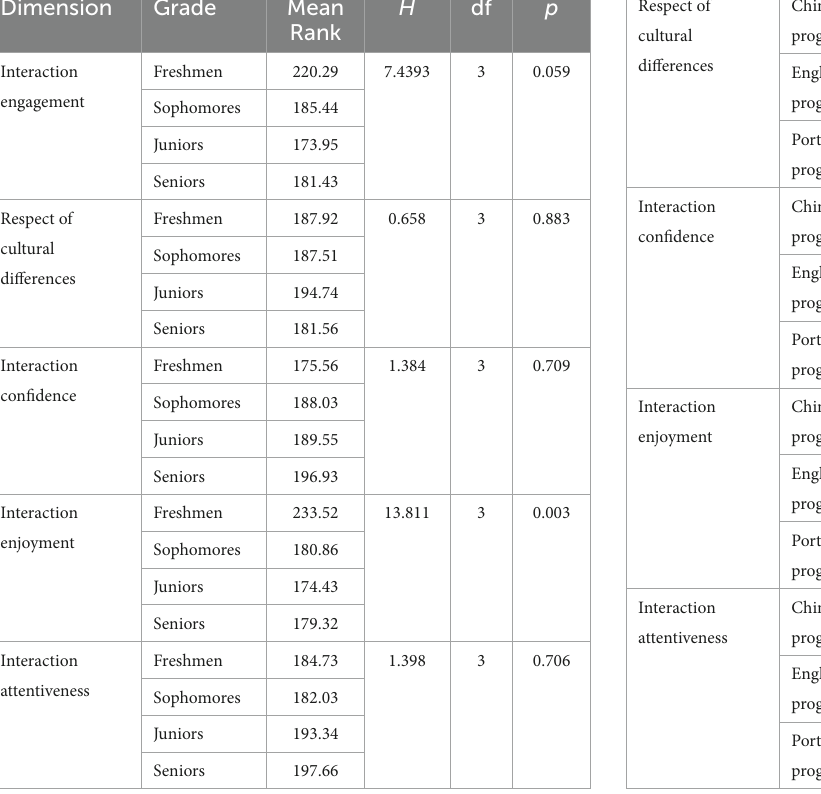
TABLE 6 Kruskal-Wallis H test for different dimensions according to grades. Dimension